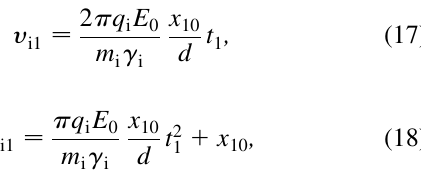
a =t ¼ 1 is used for various a 0 up 0